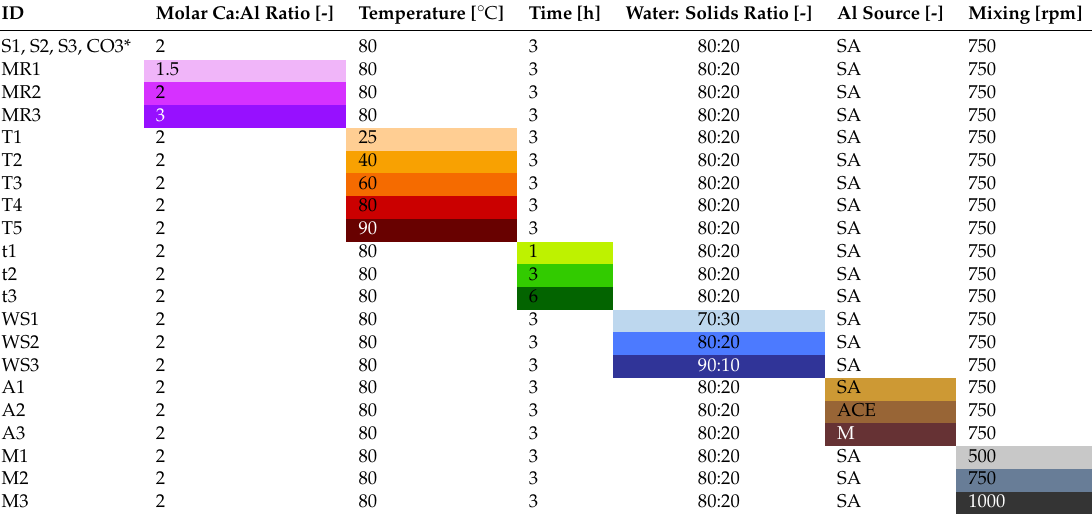
Table 7. Experimental conditions used for each of the experiments performed. The experiment IDs and colour codes defined in the table were used for each experiment in the text. Purple: molar Ca:Al ratio, red: temperature, green: time, blue: water : solids ratio, brown: Al source, grey: mixing. Note: S1, S2, S3 = MR2, T4, t2, WS2, A1 and M2. *Ca(OH) 2 used in CO3 was partially substituted with CaCO 3